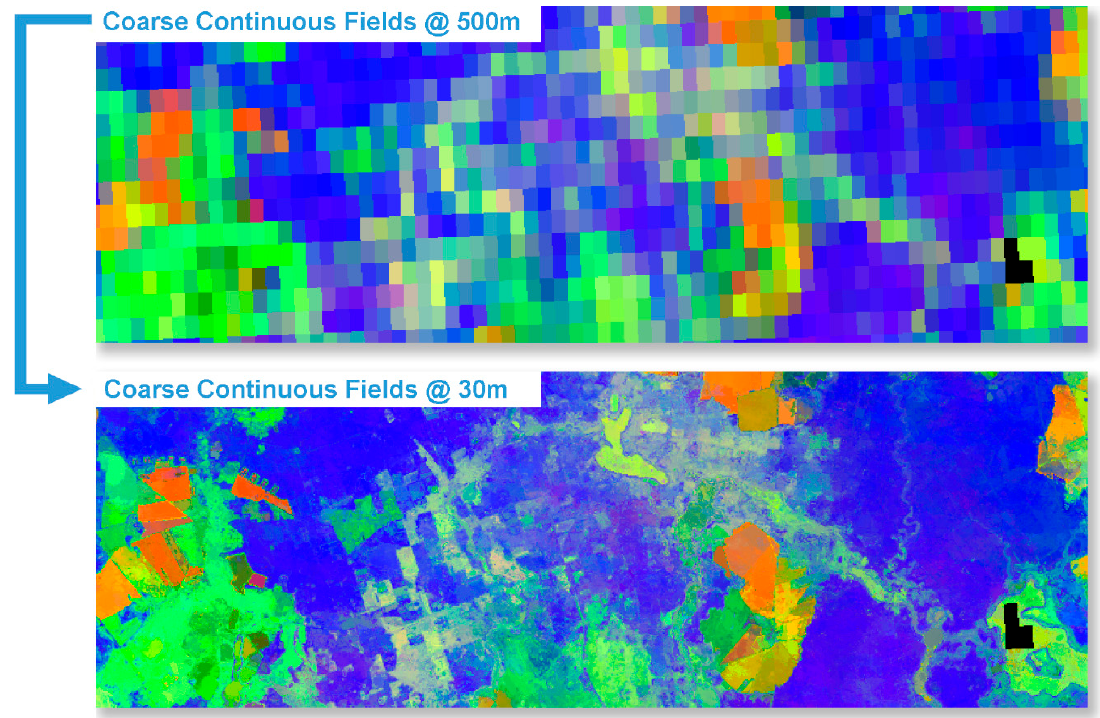
Figure 12. Land surface phenology metrics at coarse resolution (MODIS-derived, 500 m) and with improved spatial resolution at 30 m for an image subset in Brandenburg, Germany. Depicted are (rate of maximum rise, integral of green season, and value of early minimum in RGB). Using the FORCE ImproPhe module, the spatial resolution was enhanced using multi-temporal Landsat and Sentinel-2 A/B prediction targets.